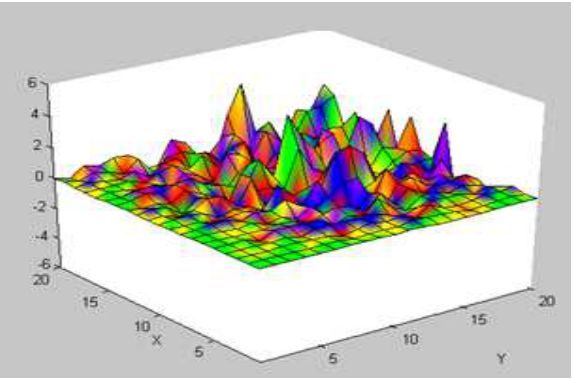
Figure 4. 3D representation of a multi-scale surface using Daubechies wavelet with multi-scale parameters (v 1 = 1.3; v 2 = 1.3; γ = 0.2 cm) P=10